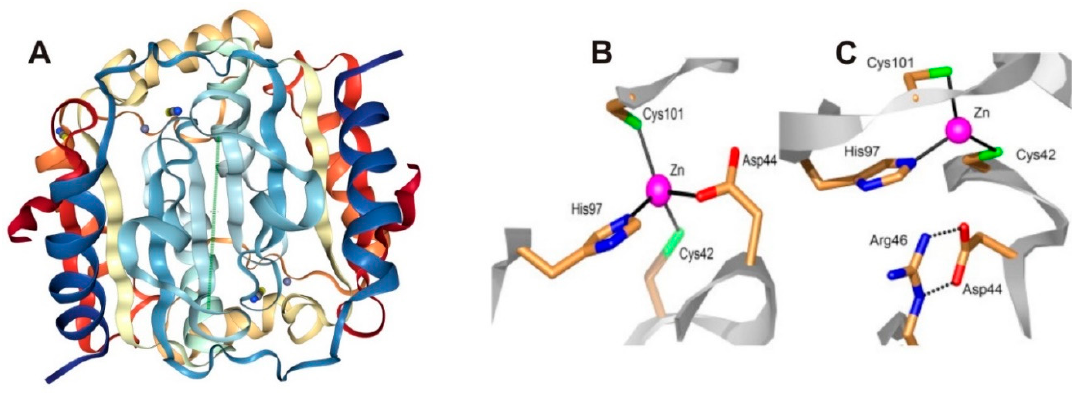
Figure 1. Crystal Structure of Rv1284 ( β -CA1) from M. tuberculosis . ( A ) Structure of β -CA1 (1YLK) [22]. Coordination of the Zn(II) ion in the β -CA1 of Mtb. ( B ) Closed active site, with the Zn(II) ion (violet sphere) coordinated by a histidine, two cysteines and one aspartate residue. ( C ) Open active site, with three protein ligands coordinated to Zn(II); the aspartate makes a salt bridge with a conserved arginine residue in all β -CAs [22,29]. The images adapted from Covarrubias et al. https://www.rcsb.org/ structure/1YLK [22]. Licensed under CC BY